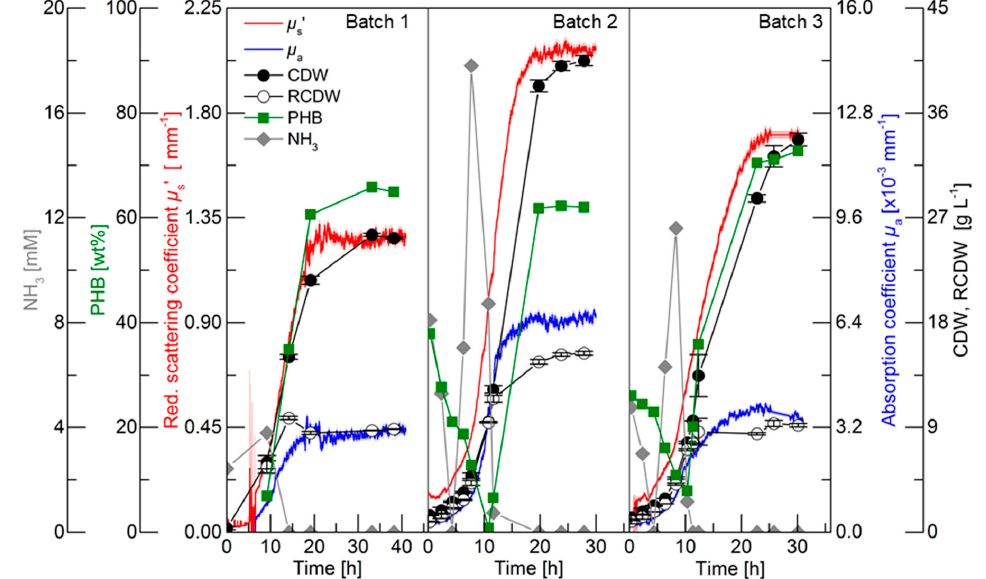
Figure 2. Batch cultivations for polyhydroxybutyrate (PHB) production by R. eutropha H16. Batch 1 contained 3% (w·v − 1 ) rapeseed oil and 2.25 g·L − 1 urea (75 mM nitrogen), Batch 2 contained 4% (w·v − 1 ) rapeseed oil and 4.5 g·L − 1 urea, and Batch 3 contained 4% (w·v − 1 ) rapeseed oil and 2.25 g·L − 1 urea. Ammonia content (grey diamonds, mM), PHB content (green squares, wt%), cell dry weight (CDW) (filled circles, g·L − 1 ), residual cell dry weight (RCDW) (empty circles, g·L − 1 ), reduced scattering coefficient µ s ’ (red line, mm − 1 ), and absorption coefficient µ a (blue line, ×10 − 3 mm − 1 ) at 638 nm are shown. Error bars indicate minimum and maximum values of technical duplicates.